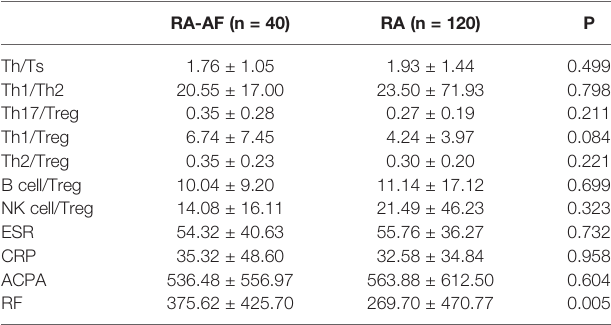
TABLE 3 | Ratios of peripheral lymphocyte subsets and in fl ammatory biomarkers in patients with RA-AF and